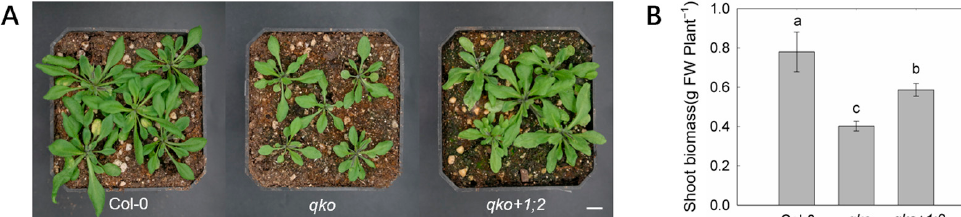
Figure 9. Growth of the wild type (Col-0), the quadruple insertion line qko and the transgenic line expressing MhAMT1;2 (qko+1;2) . ( A ) Growth of Col-0, qko and qko+1;2 plants for six weeks. Bar = 1 cm. ( B ) The shoot fresh weight (FW) of Col-0, qko and qko+1;2 plants in ( A ). Bars labelled with different letters indicate significant di ff erence.